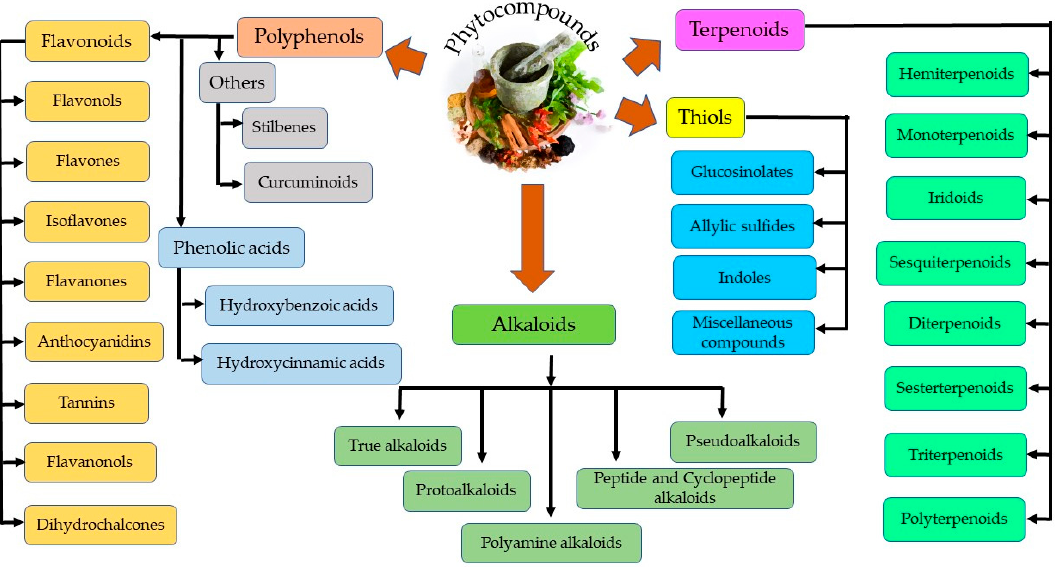
Figure 2. Different classes of phytocompounds.